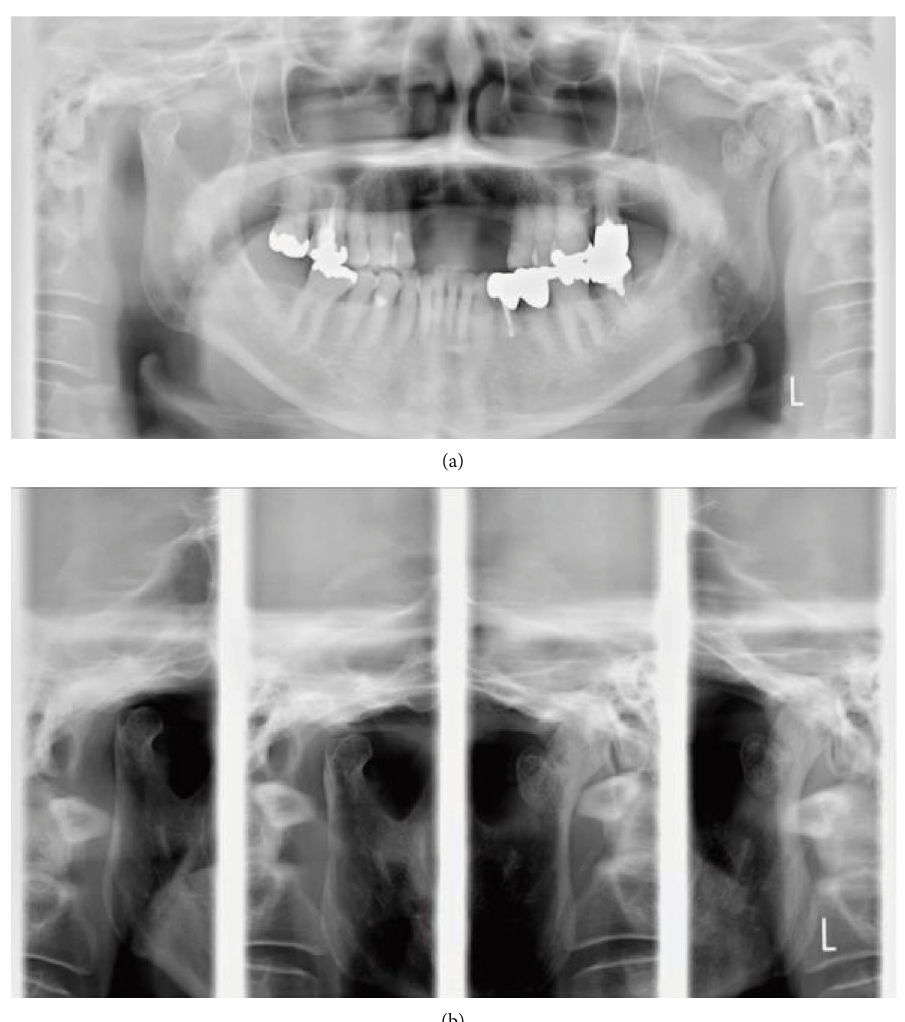
Figure 2: Radiographic fi ndings: (a) panoramic radiograph and (b) lateral projection of the temporomandibular